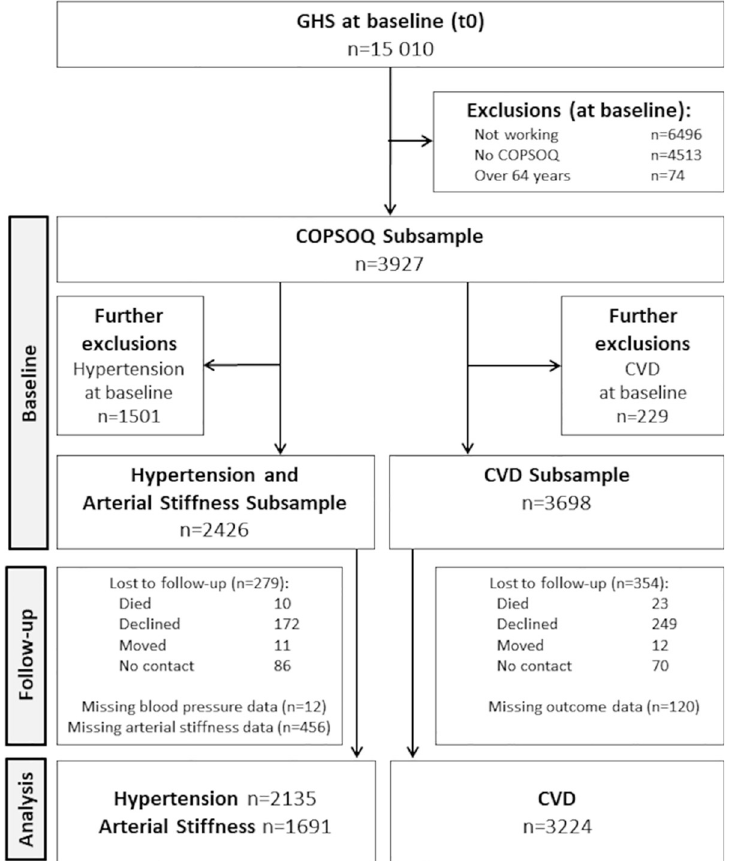
Fig 1. Study flow chart describing the selection of the hypertension/arterial stiffness and the CVD